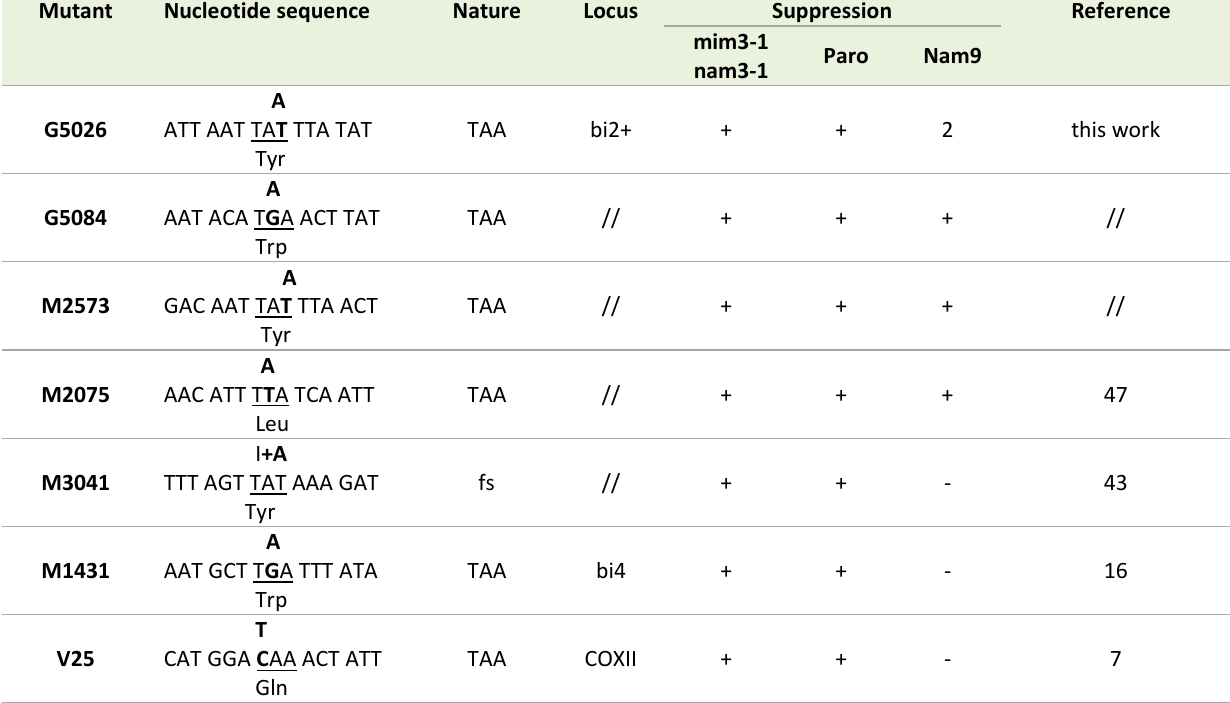
TABLE 1. Nucleotide sequence of mitochondrial mutations suppressed either by the 15S mitochondrial ribosomal RNA mutation mim3-1 or by the dominant nuclear mutation Nam9-1 encoding the ribosomal protein S4 or by the recessive nuclear mutation